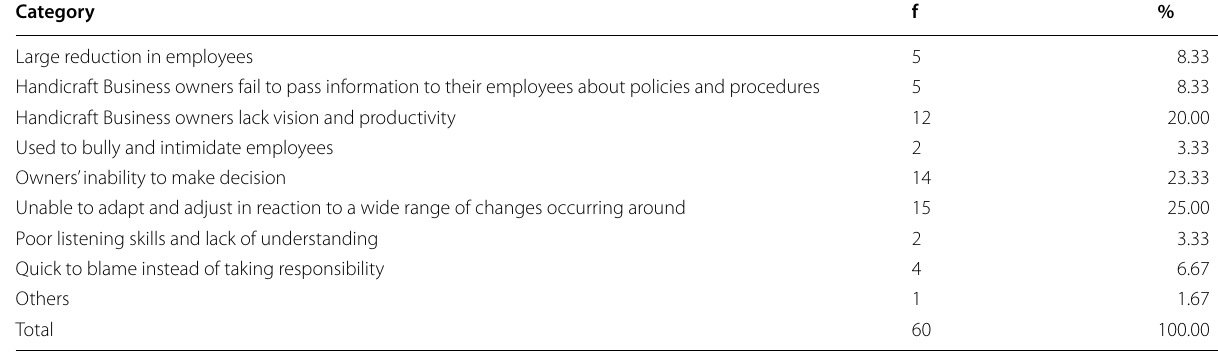
Table 10 Determinants of the problems encountered by the respondents that lead to handicraft business failure in terms of staffing and